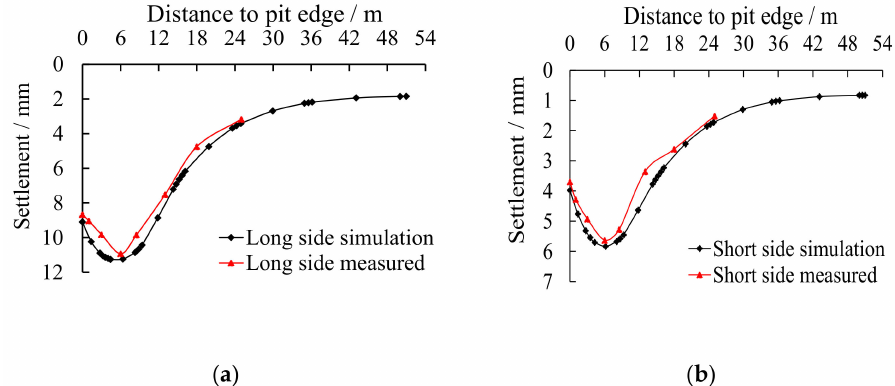
Figure 13. Ground settlement: ( a ) HH section of the long side, ( b ) KK section of the short